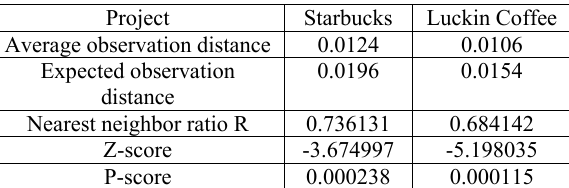
Table 1 . Average Nearest Neighbor Analysis Results.